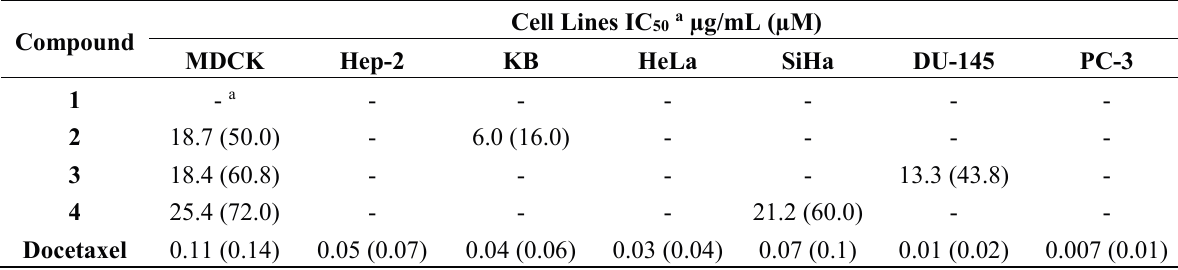
Table 4. Antiproliferative activity (IC 50 ) of compounds isolated from A. fascicularis root bark.